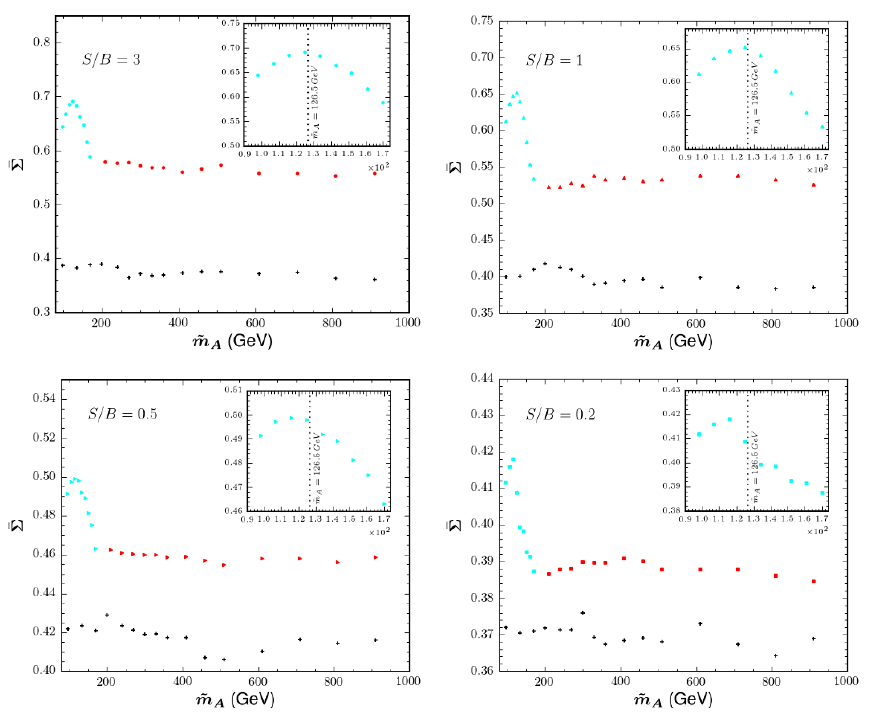
Figure 23 . The same as (cid:12)gure 11, but now taking point P direction depicted in (cid:12)gure